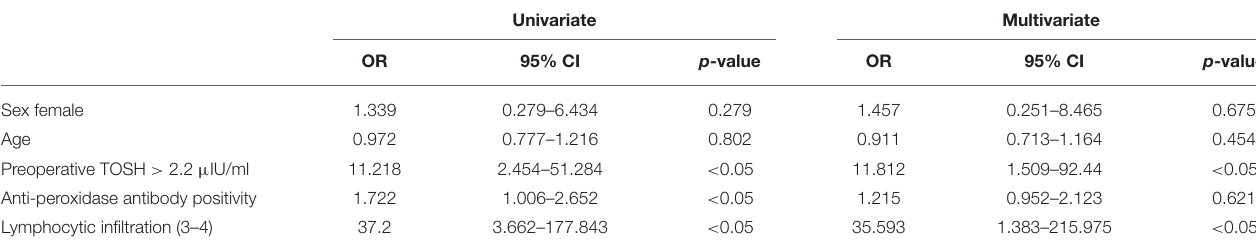
TABLE 2 | Univariate and multivariate analyses for the development of